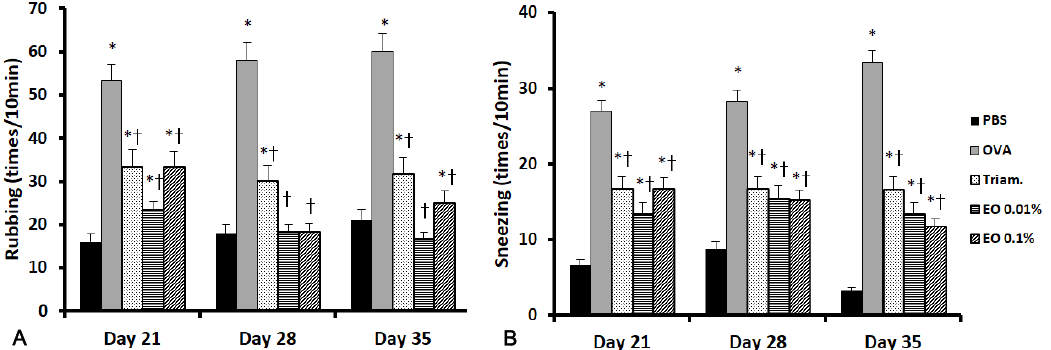
Figure 1. Effects of essential oil from Chamaecyparis obtusa (EOCO) in the allergic rhinitis mouse model (n = 8 mice per group). The frequency of nasal rubbing ( A ) and sneezing ( B ) counts was significantly decreased with intranasal instillation of triamcinolone (Triam.) and EOCO. PBS, phosphate-buffered saline; OVA, ovalbumin; * ( p < 0.05) versus the PBS group; † ( p < 0.05) versus the OVA group.